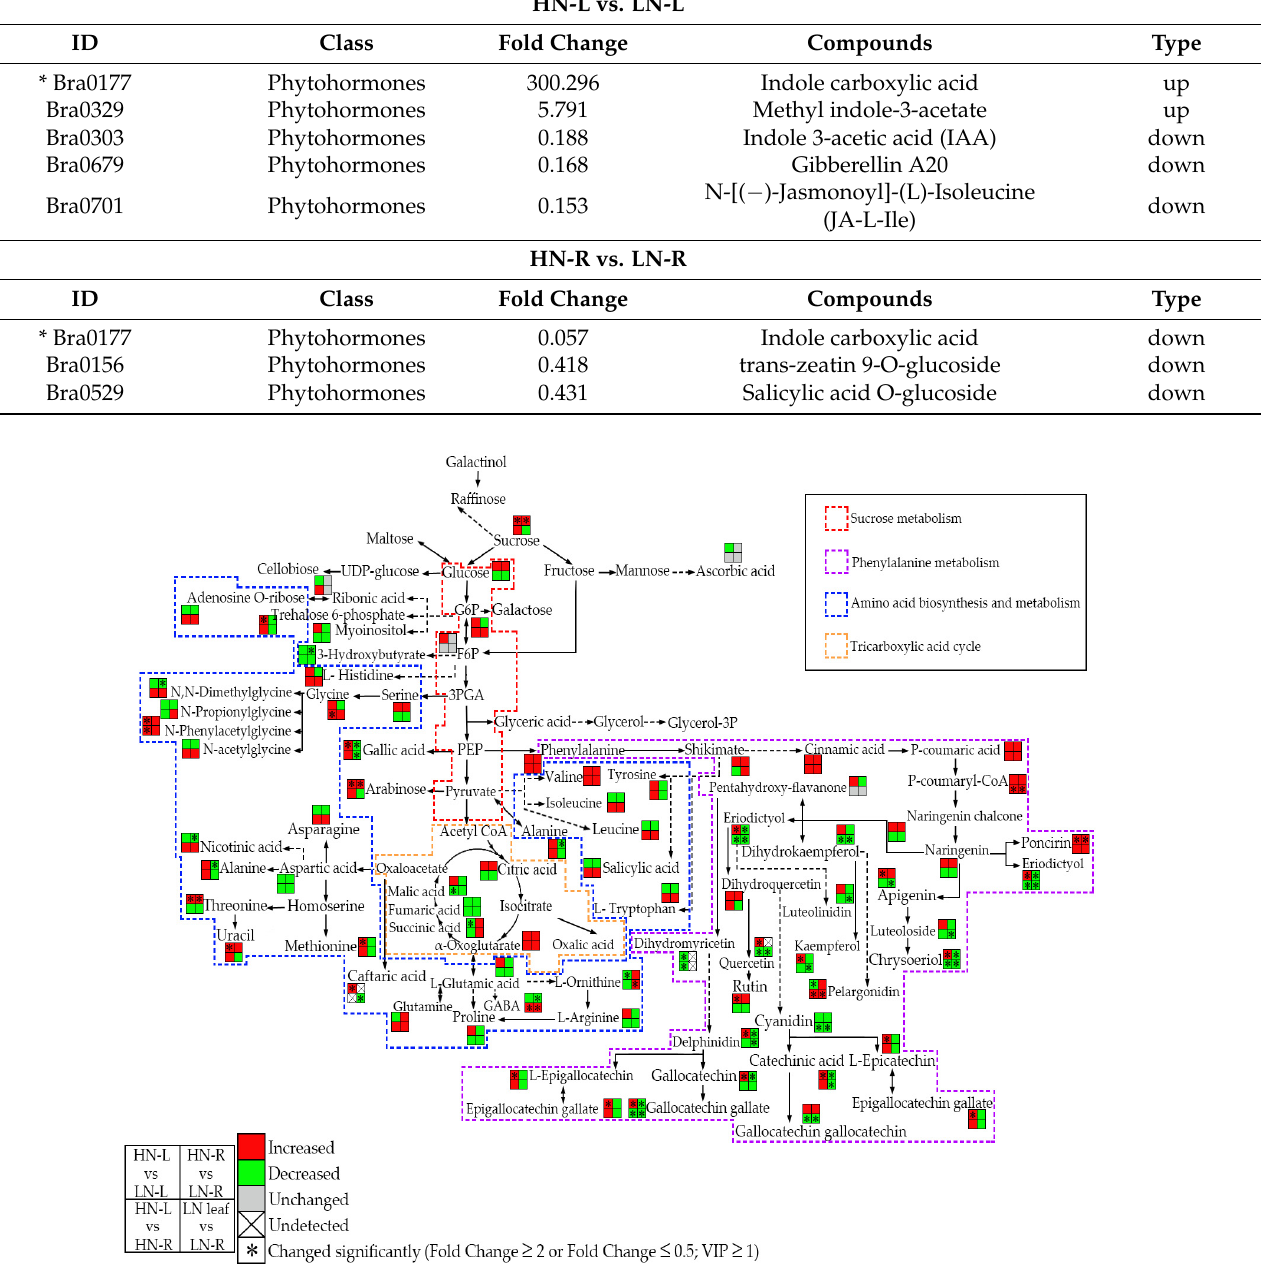
Figure 6. Schematic presentation of the pathway of certain important metabolites whose accumula- tion is affected by HN or LN conditions in the leaves and roots of rapeseed. The red represents an increase, while the green represents a decrease. The colored dotted boxes represent important met- abolic pathways. The solid black arrow represents a direct reaction, while the black dotted arrow represents an indirect reaction. The asterisk marks indicate that the relative levels of metabolites were significantly different (fold change > 2 or fold change < 5). VIP > 1.